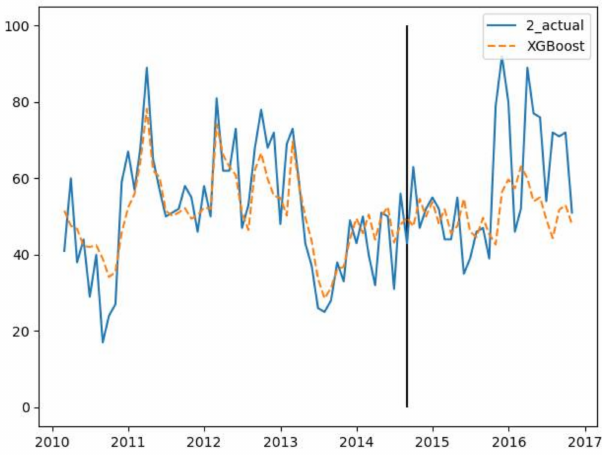
Figure 6. GBDT’s fitting and prediction results for group 2.